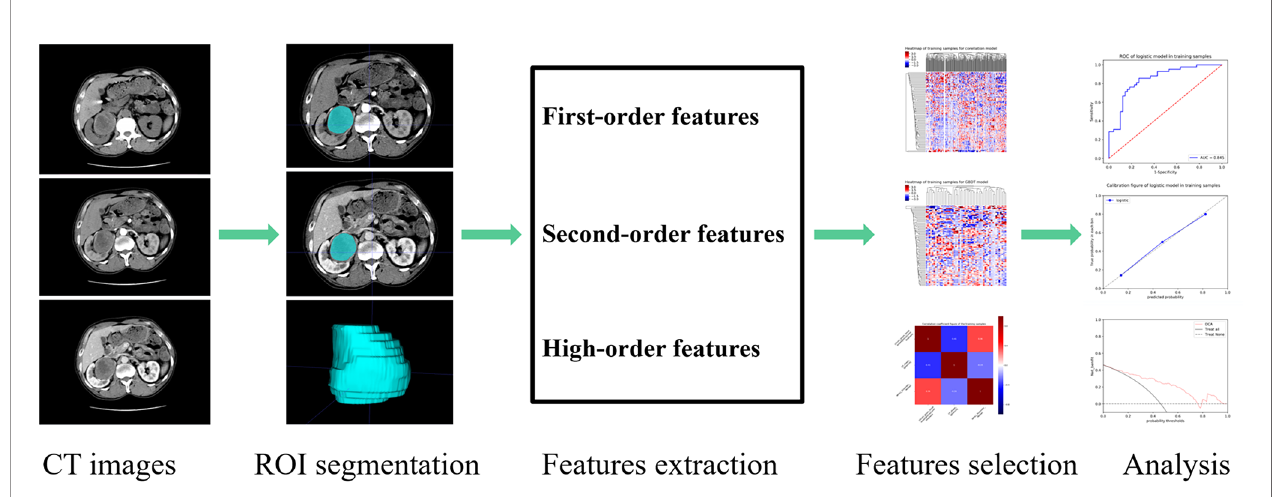
FIGURE 2 | Papillary renal cell carcinoma (pRCC) study radiomics fl ow